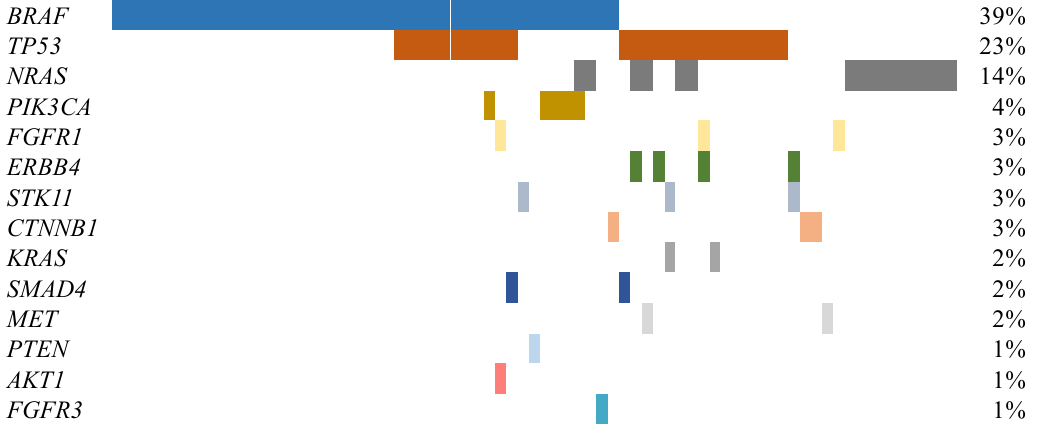
Figure 4. Spectrum of genes with alterations identified in 115 advanced melanomas. The percentage of samples with an alteration detected is noted at the right. Samples with an alteration identified are displayed as columns ( N = 75)